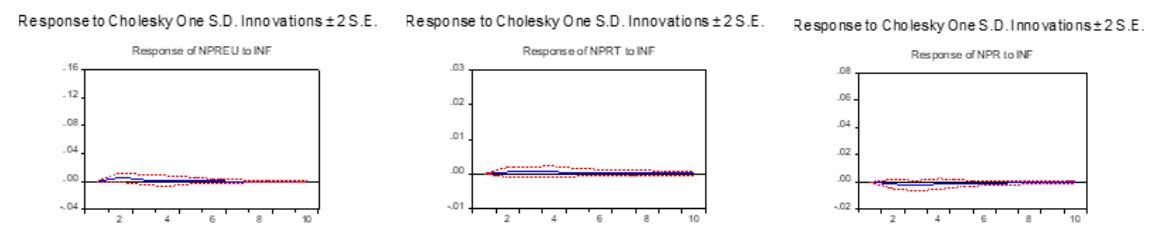
Figure 2C. Before the COVID-19 outbreak (outside Java Island)